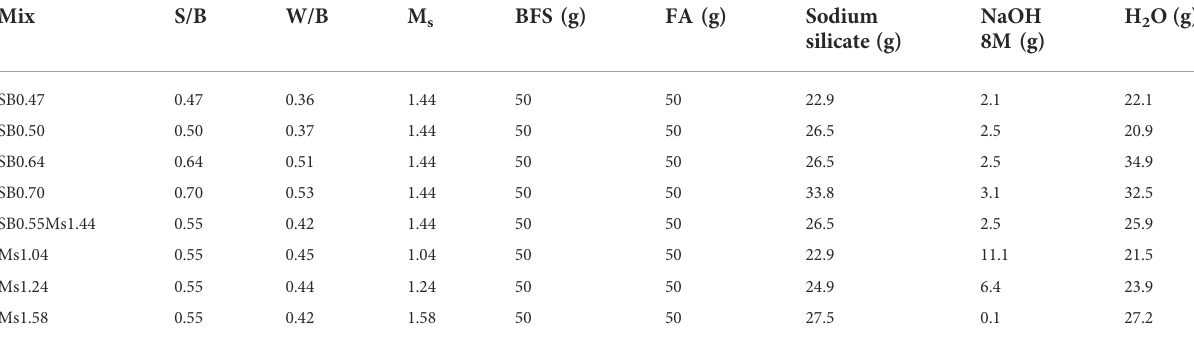
TABLE 2 Mix proportions of the tested AASF pastes.